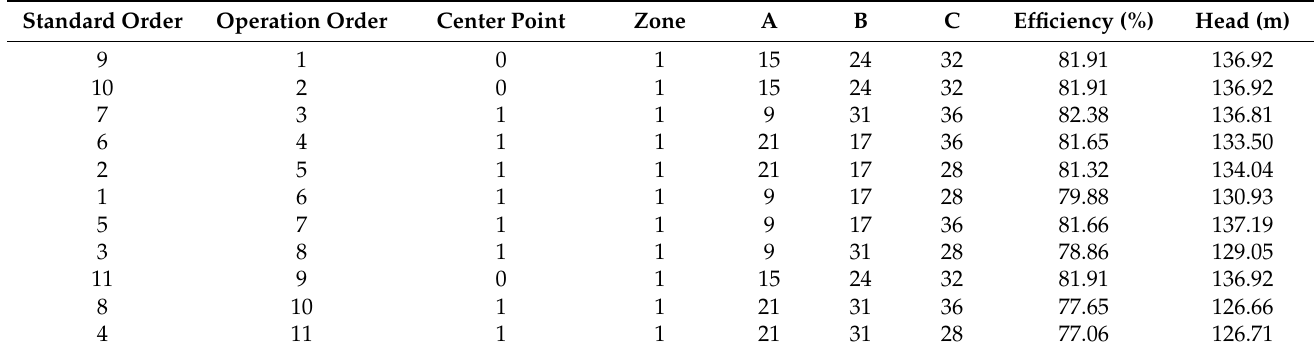
Table 6. Full-factorial experimental design scheme and results of calculation.